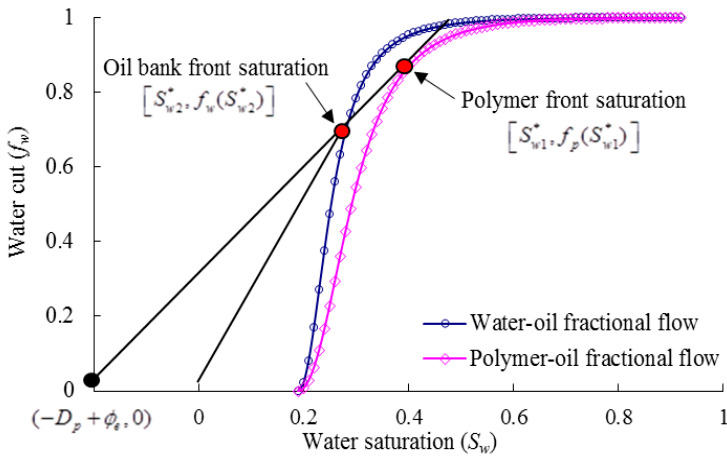
Figure 2. Fractional flow curves of water flooding and polymer flooding.